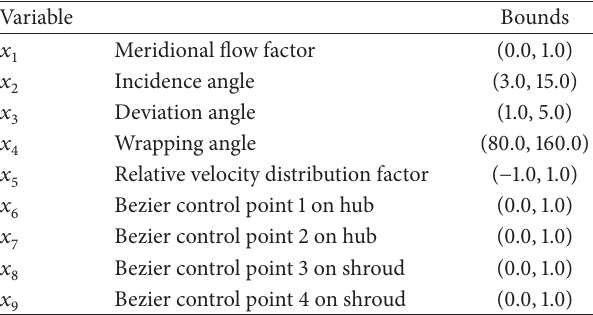
Table 1: Optimal variables.